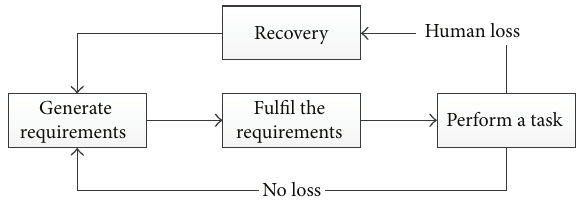
Figure 4: The activity circle of action